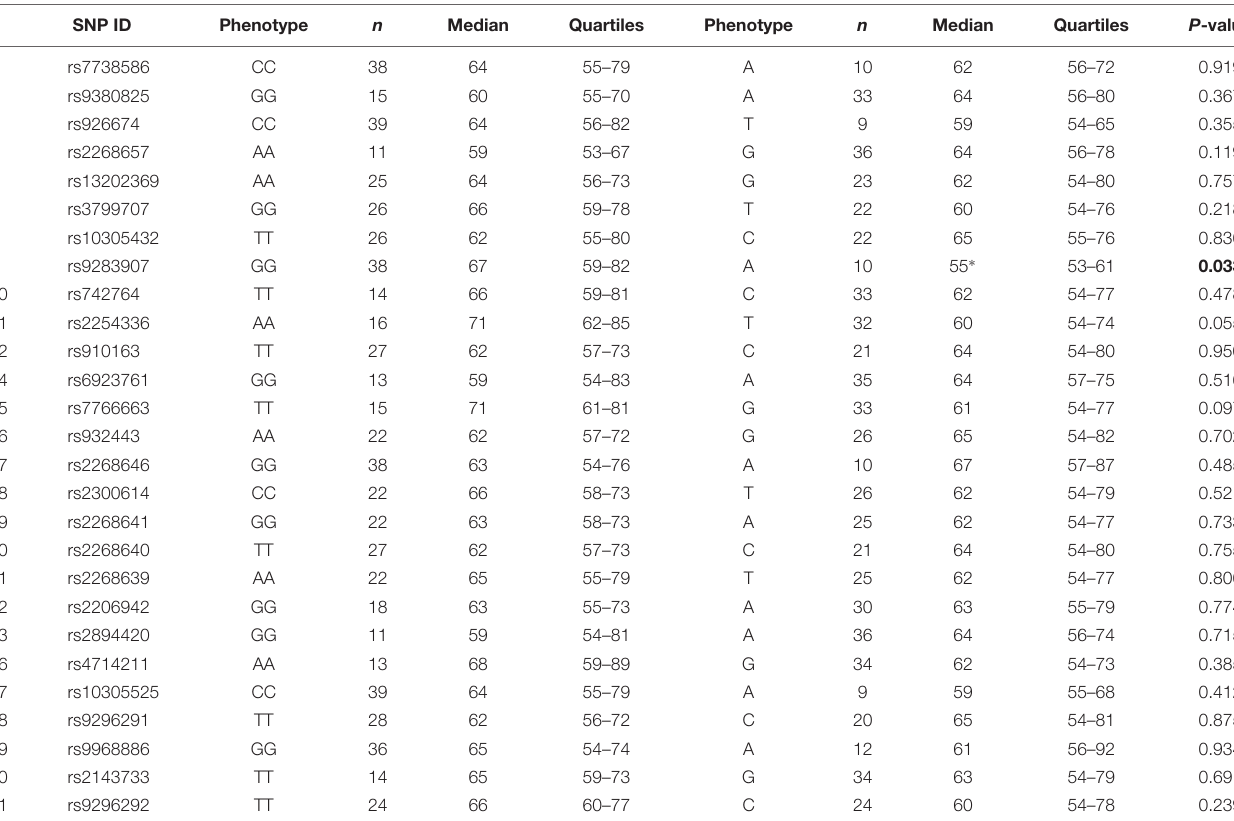
results according to 2